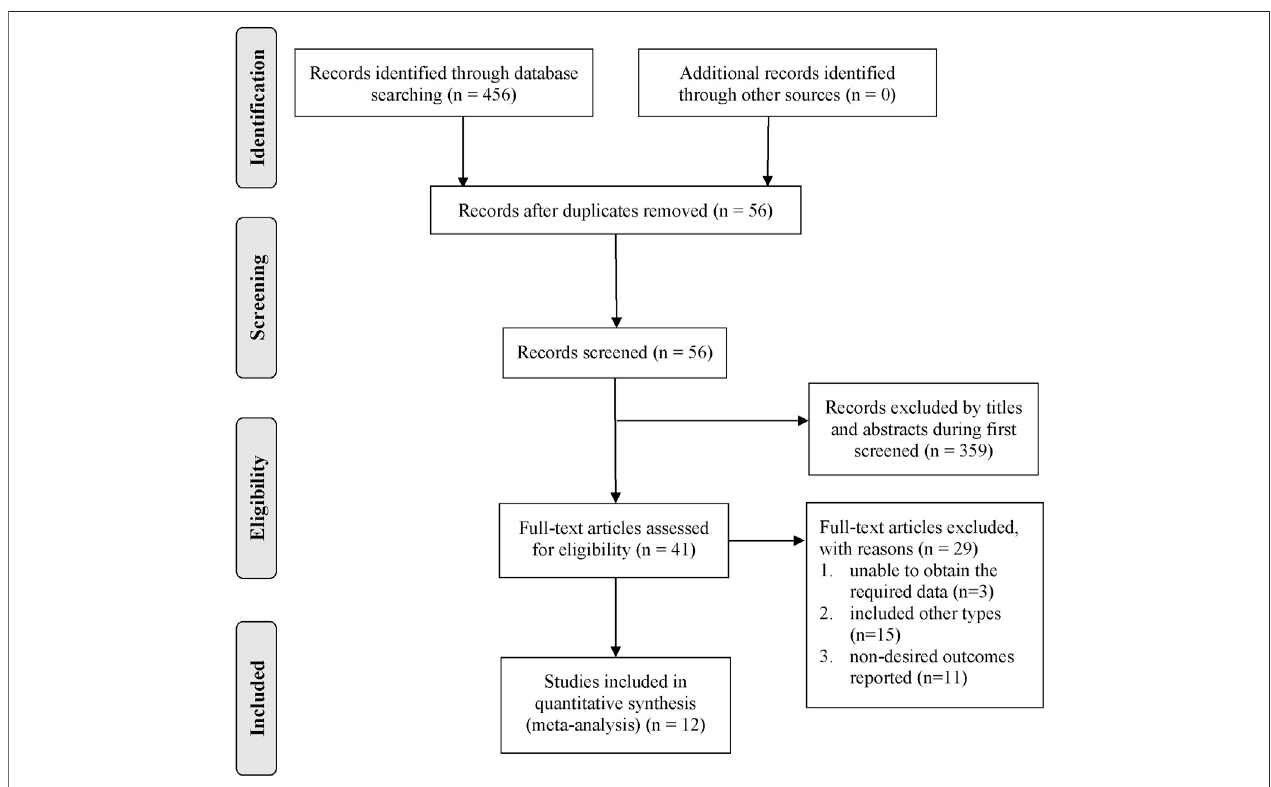
FIGURE 1 | Summarizes the detailed search